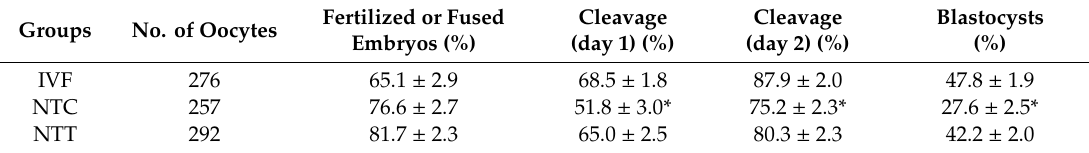
Table 1. Vc treatment improved the preimplantation development of cloned embryos. Groups